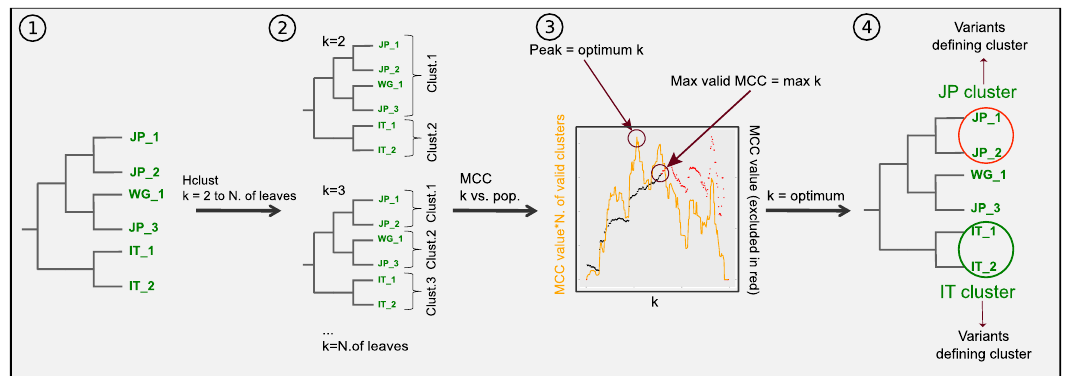
Figure 3. Clustering workflow. For each gene, ( ① ) a maximum likelihood phylogenetic tree is generated. ( ② ) Hierarchical clustering is used to generate groupings that separate the isolates in increasing number of clusters. ( ③ ) For each grouping a similarity value with the geographical origin of the isolates is calculated (see methods), as well as the number of valid clusters (i.e., clusters containing at least 3 isolates). The optimum clusterisation is determined as the one giving the highest similarity value for the maximum number of valid clusters. ( ④ ) The grouping with the optimum number of clusters is taken and for each cluster the odds ratios for the presence of isolates of each population is calculated. The polymorphic positions found in each clusters/origin pair with high odds ratios undergo analysis to calculate statistical significance of the presence of each allele.